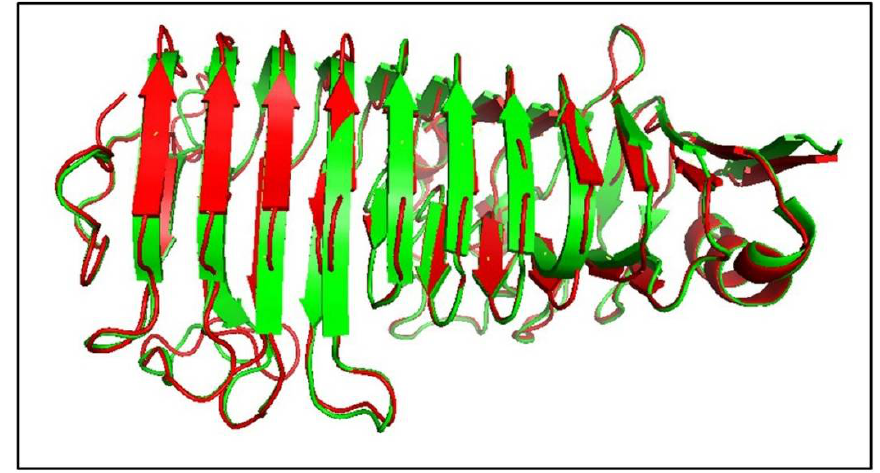
Figure 1. Structure modelling of AnEPG. Superimposition of structures of modelled AnEPG (red) and AaEPG (PDB ID: 1IA5) (green) [33]. The amino acid sequence identity between AnEPG and AaEPG was 57.8%.